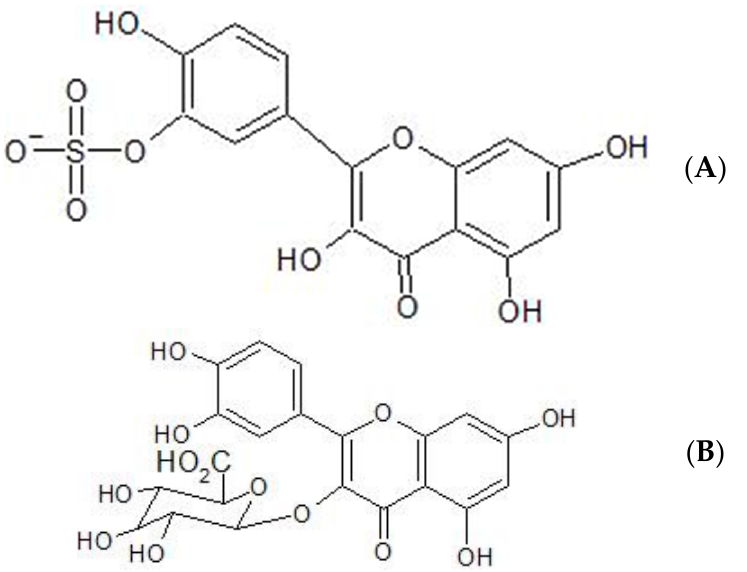
Figure 2. Molecular structure of ( A ) quercetin-3 ′ -sulphate ( B ) quercetin 3-O- β -D-glucuronide.